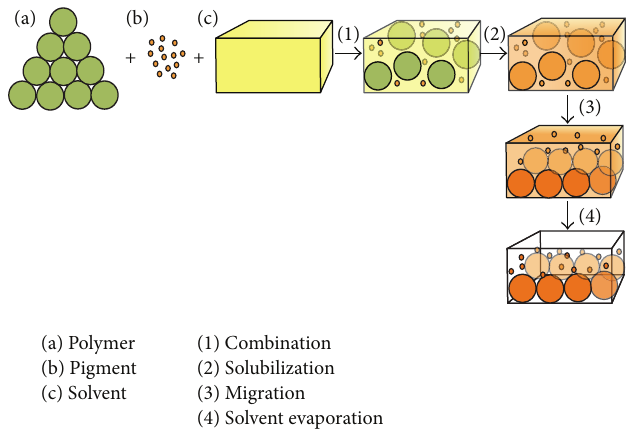
Figure 2: Steps of pigments addition to the UHMWPE through ethanol followed by the solvent evaporation.